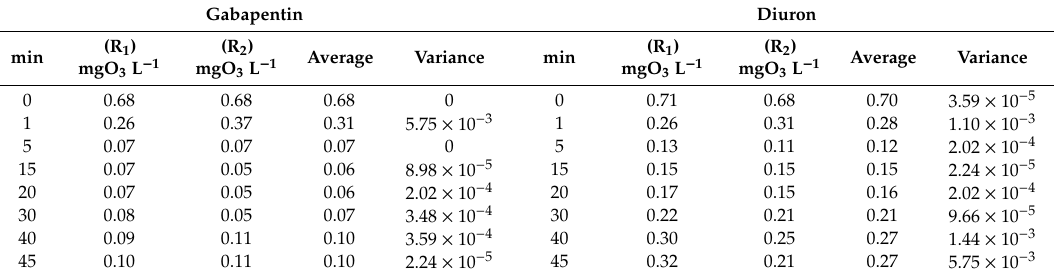
Table 4. Ozone inlet levels and fall in concentration throughout the